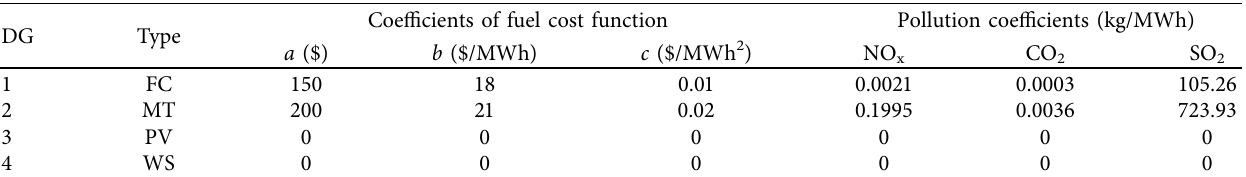
Figure 3: Expected daily curve of (a) load factor [57], (b) energy price, and (c) RES power rate [58]. Table 2: DGs characteristics.